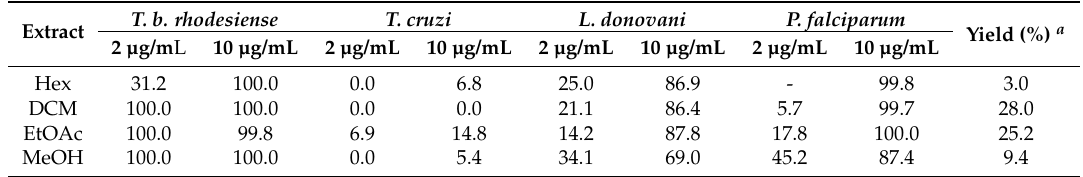
Table 1. In vitro growth inhibition (%) of Aldama discolor crude extracts against T. b. rhodesiense , T. cruzi , L. donovani and P. falciparum . DCM, dichloromethane.